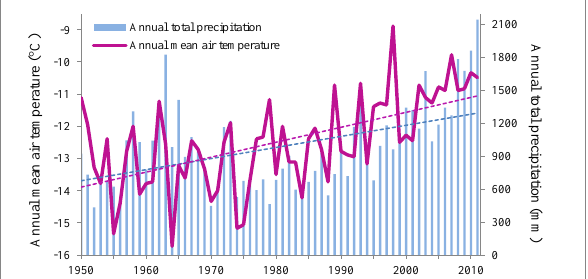
Fig. 2. 1950–2011 annual mean air temperature and total precipita- Figure 2. 1950-2011 annual mean air temperature and total precipitation (rain and snowfall) tion (rain and snowfall) as recorded at the National Weather Service as recorded at the National Weather Service station, Barrow, AK. The dashed lines indicate 770 station, Barrow, AK. The dashed lines indicate the trend for annual the trend for annual mean air temperature (2.9 °C increase in 62 years, α = 0.001) and for mean air temperature (2.9 ◦ C increase in 62yr, α = 0.001) and for annual total precipitation (639 mm increase in 62 years, α = 0.001). annual total precipitation (639mm increase in 62yr, α =